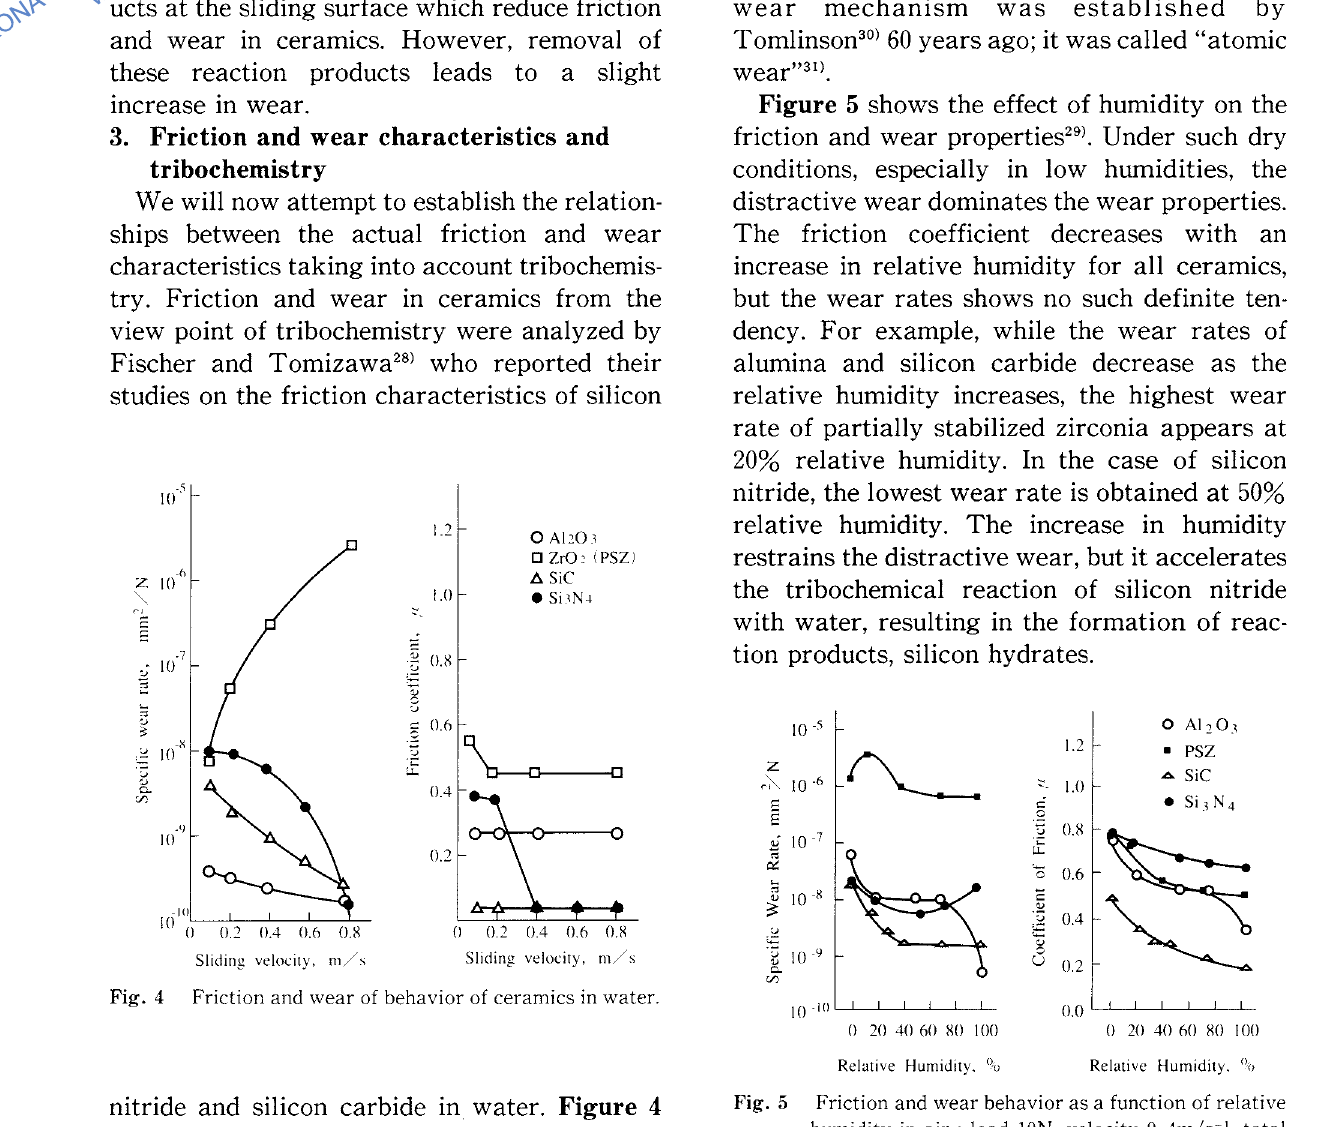
Fig. 5 Friction and wear behavior as a function of relative humidity in air: load lON, velocity 0.4m/s- 1, total wear distance